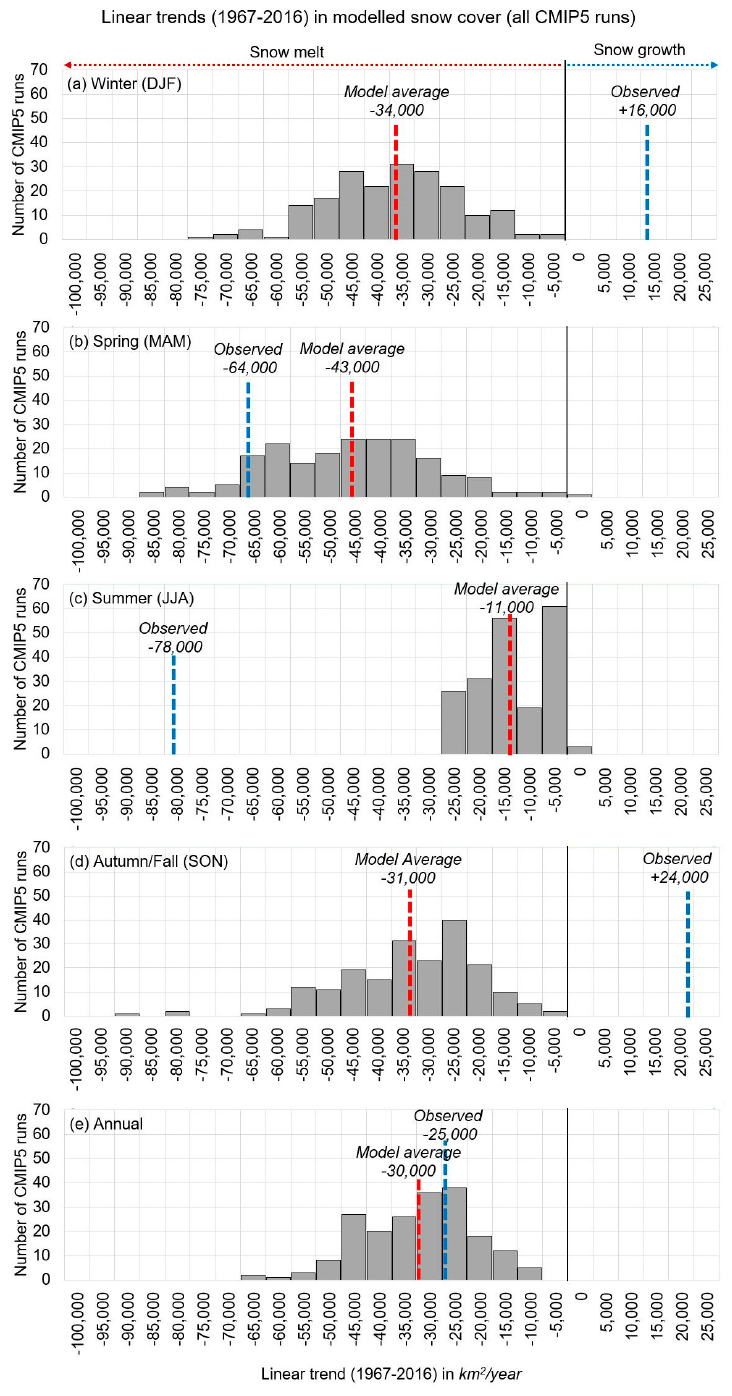
Figure 2. Estimated 1967–2016 Northern Hemisphere snow cover area for each of the 196 CMIP5 simulations for ( a ) winter, ( b ) spring, ( c ) summer, ( d ) autumn/fall, and ( e ) annual averages. The observed areas for each season (or yearly average) are indicated with dashed, blue lines in each panel.